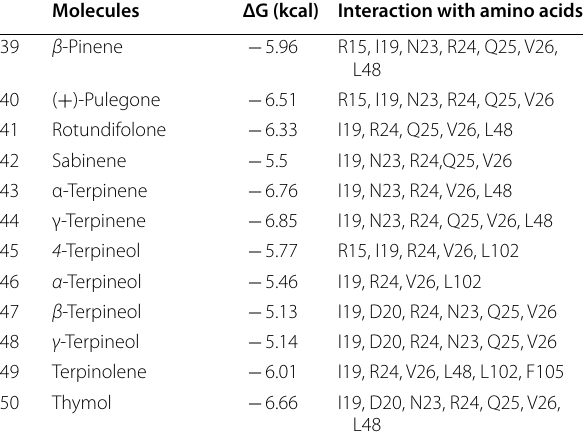
Table 8 Docking results by SCP-2 from Culex quinquefas-